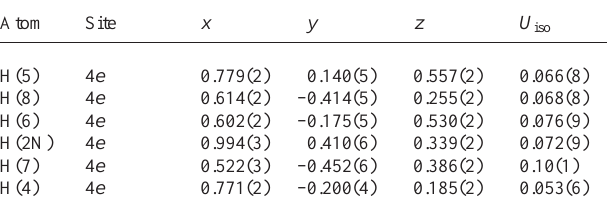
Table 2. Atomic coordinates and displacement parameters (in Å 2 )